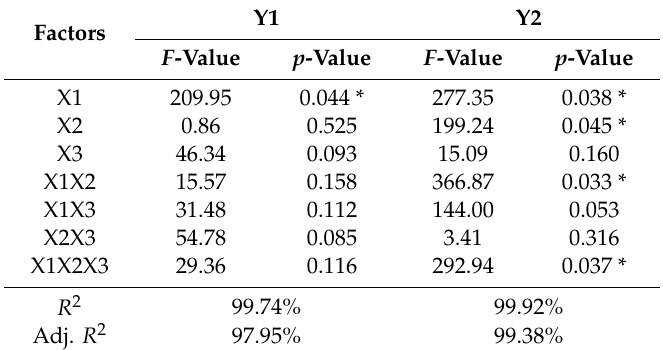
Table 2. Statistical analysis of variance (ANOVA) of the responses (Y1 and Y2) results.